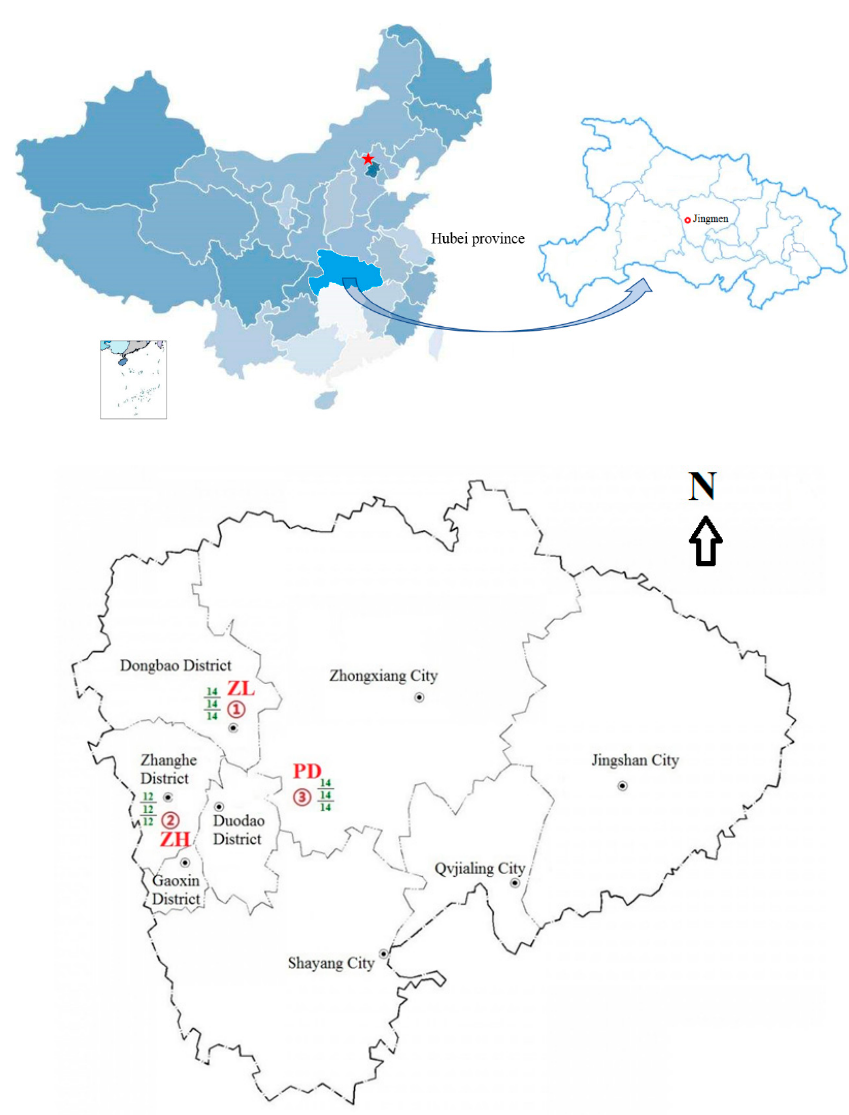
Figure 1. Geographical locations of sampling site details in an administrative map (1:6,000,000) of Jingmen city. ZL (14 / 14 / 14), Zilingpu (14 fruit sample / 14 leaf sample / 14 soil sample); ZH (12 / 12 / 12), Zhanghe (12 fruit sample / 12 leaf sample / 12 soil sample); PD (14 / 14 / 14), Pengdun (14 fruit sample / 14 leaf sample / 14 soil